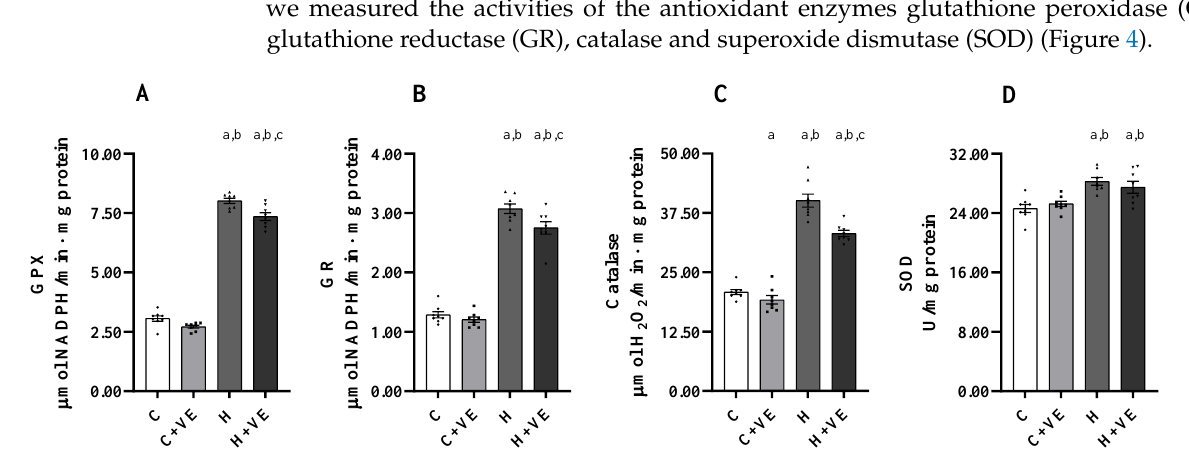
D Figure 3. Total ROS content ( A ), NADPH oxidase (NOX) O2- release ( B ), mitochondrial H2O2 re- lease during basal ( C ) and ADP-stimulated respiration ( D ). C control rats; C + VE, vitamin-E-fed rats; H hyperthyroid rats; H + VE hyperthyroid and vitamin-E-fed rats. Values are the means ± SEM of eight different rats. p < 0.05 was chosen as the significance level. Meaning of the letters: a, p < 0.05 vs. C; b, p < 0.05 vs. C + VE; c, p < 0.05 vs. H (one-way ANOVA followed by Tukey post-test). Mitochondrial ROS release was measured during basal (Figure 3C) and ADP-stimu- lated respiration (Figure 3D). The highest mitochondrial ROS release was observed in the H group, during basal and ADP-stimulated respiration. Vit E supplementation reduced ROS release during basal and ADP-stimulated respiration both when administered to C and H rats. Overall, these data suggest that increased oxidative damage occurs in hyperthyroid-